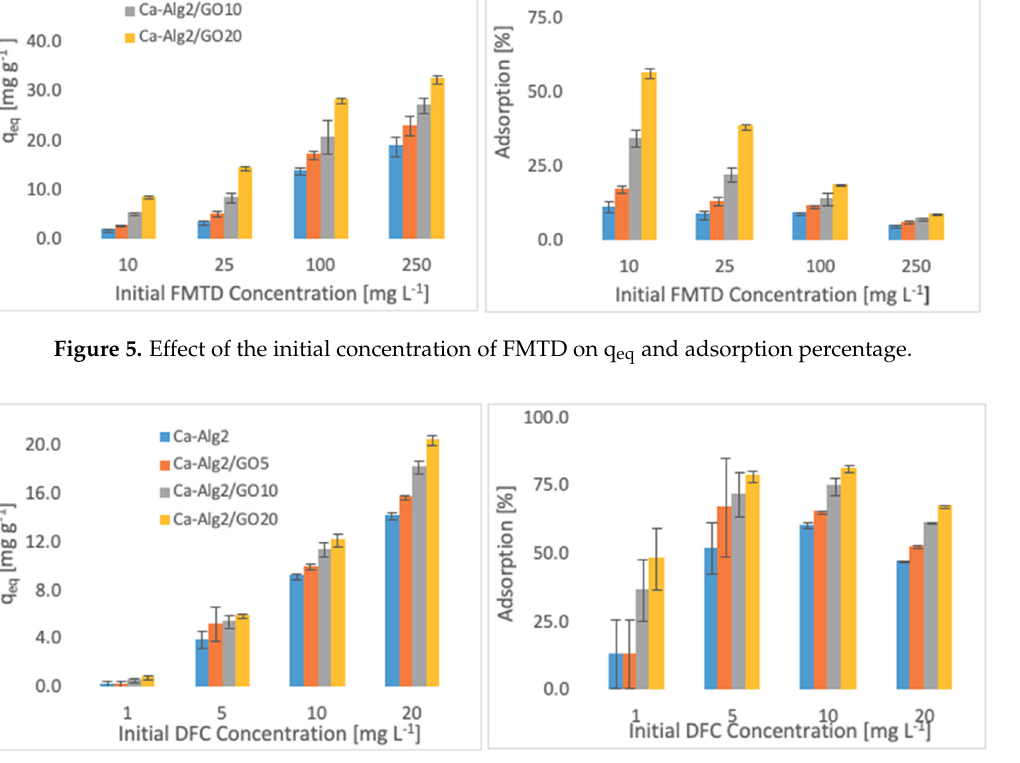
Figure 6. Effect of the initial concentration of DFC on q eq and adsorption percentage.